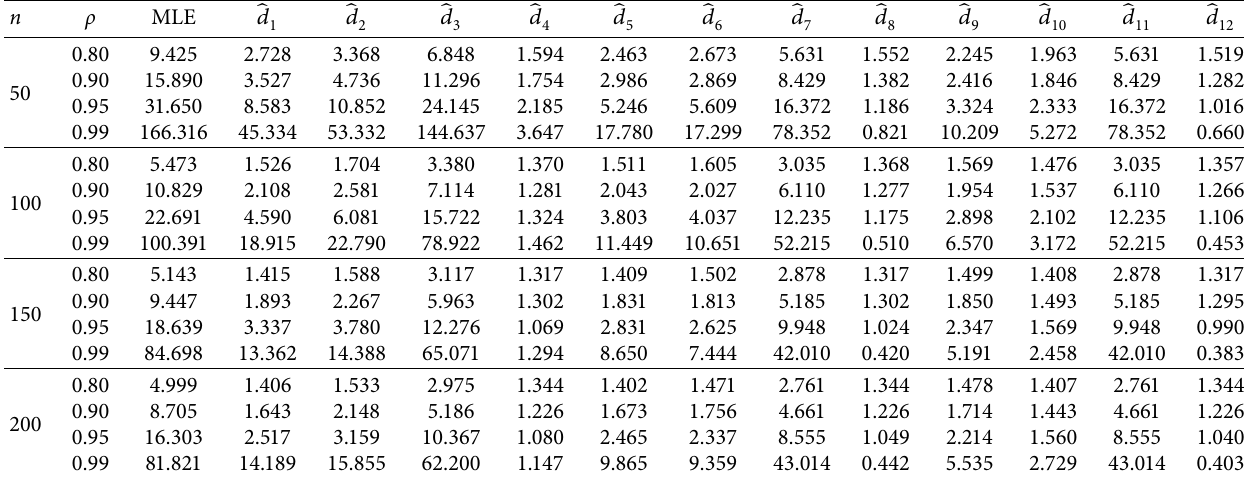
Table 5: Estimated MSEs of the COMPRM estimators, when p � 6 and ϑ �